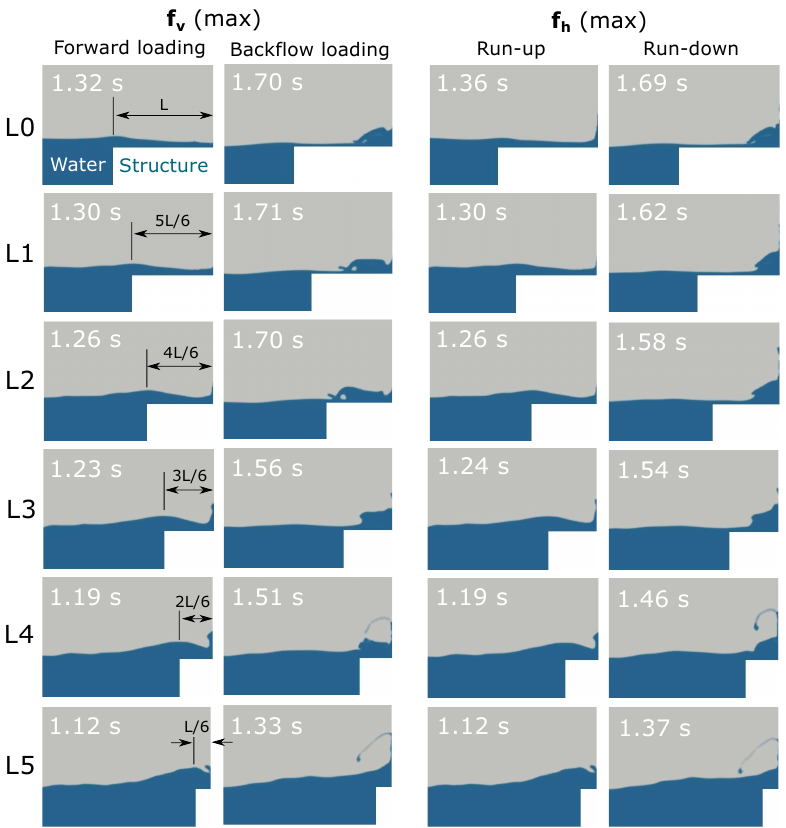
Figure 13. Snapshots that represent the stages at which the maximum f v and f h loads ocurred during forward and backflow loading stages, for different deck lengths (cases L0–L5). Note that the domain was reduced from right to left, leaving the same distance for wave development in all